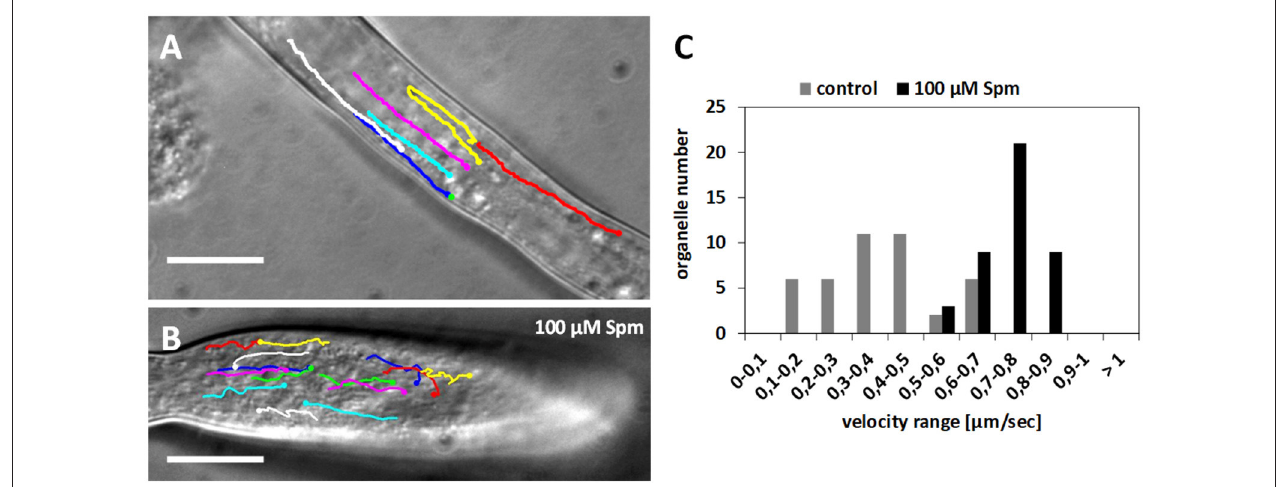
FIGURE 7 | Velocity distribution of organelles in control and Spm-treated pear pollen tubes. (A) Control pollen tube with lines indicating the pathway of some monitored organelles. (B) Pathway of some organelles in a Spm-treated pollen tube. Bars: 10 µ m. (C) Velocity distribution of representative organelles in control and Spm-treated pollen tubes. The Y-axis indicates the number of organelles while the X-axis indicates the velocity (in µ m sec − 1 ).